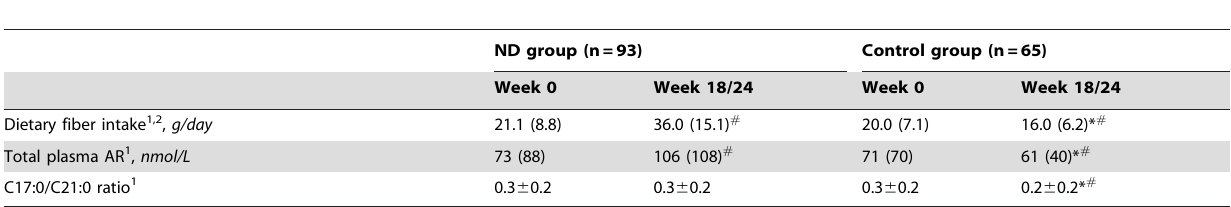
Table 2. Dietary fiber intake, total plasma alkylresorcinols (AR) concentration and AR C17:0/C21:0 ratio for the healthy Nordic diet group (ND) and control group at baseline and after the 18/24 week intervention.